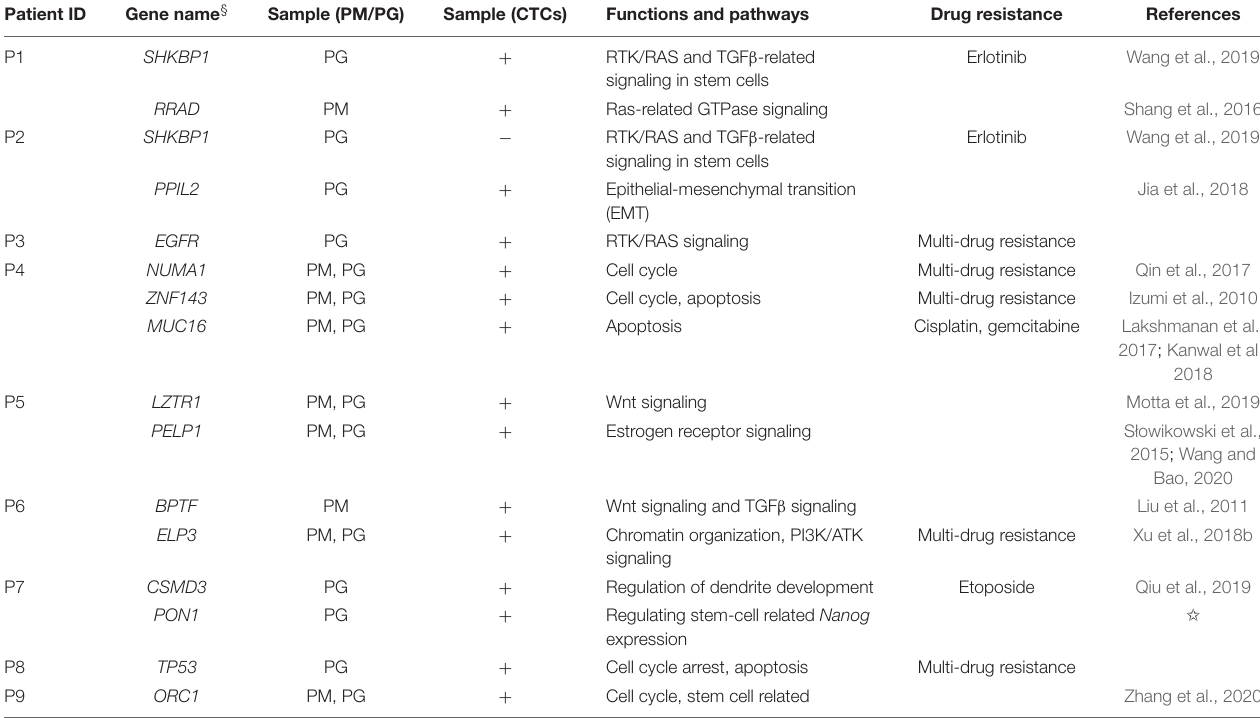
TABLE 2 | Genetic information identified in CTCs of platinum-drug resistance